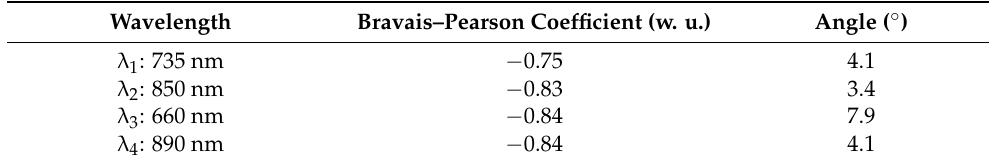
Table 3. Correlation analysis of reflection mode versus transmission mode. (w. u.: without unit; °: degree).